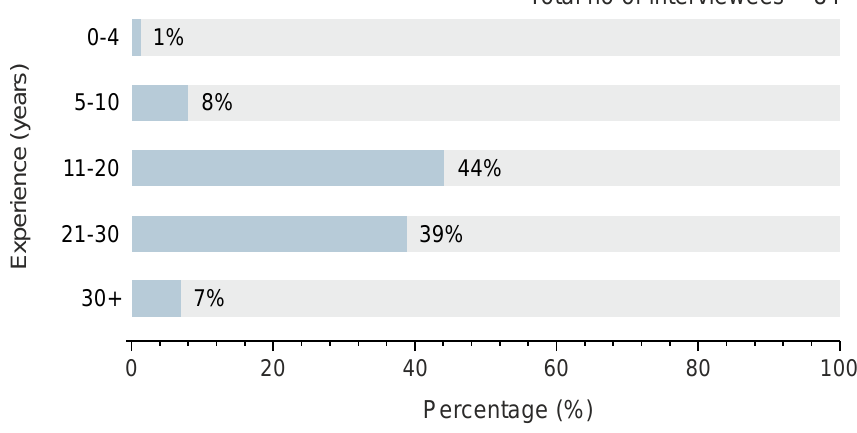
Figure 1. Age composition of teachers interviewed (percentages do not sum to 100 due to round- ing).